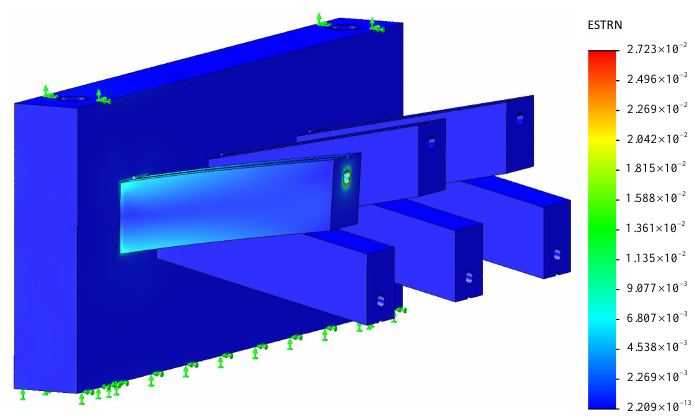
Figure 7. The FEM analysis of one beam of the sensor in the maximum value of the cable tension 70N.